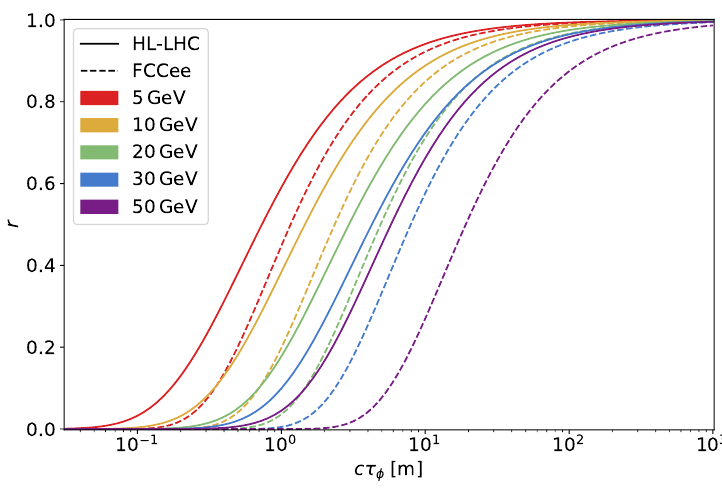
Figure 6 . The rescaling factor r defined in eq. (3.6) as a function of cτ φ for the HL-LHC and FCCee. The dependence at the LHC is comparable to the HL-LHC. The larger r , the more singlets escape the detector before